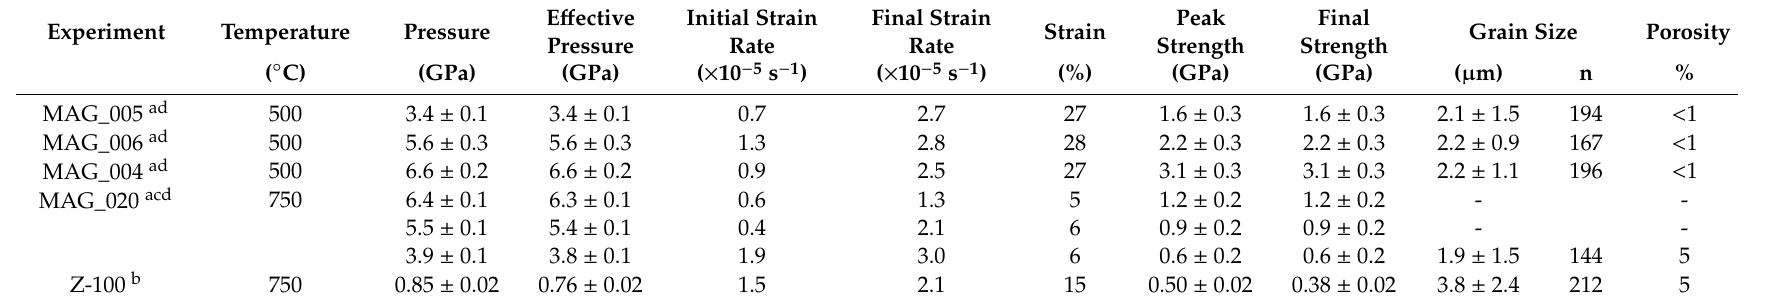
Table 2. List of experiments performed on fine-grained Nevada magnesite.